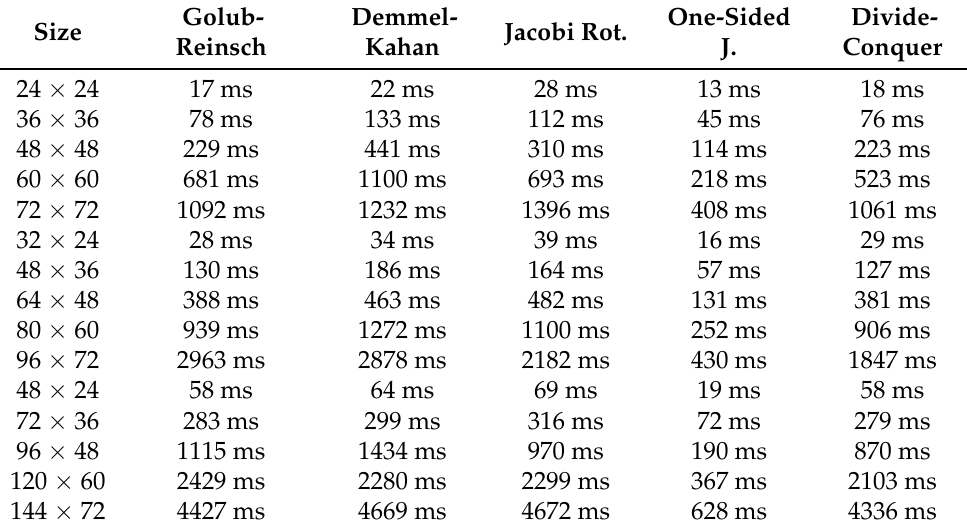
Table 5. Timings of SVD algorithms on Cortex-M4F.